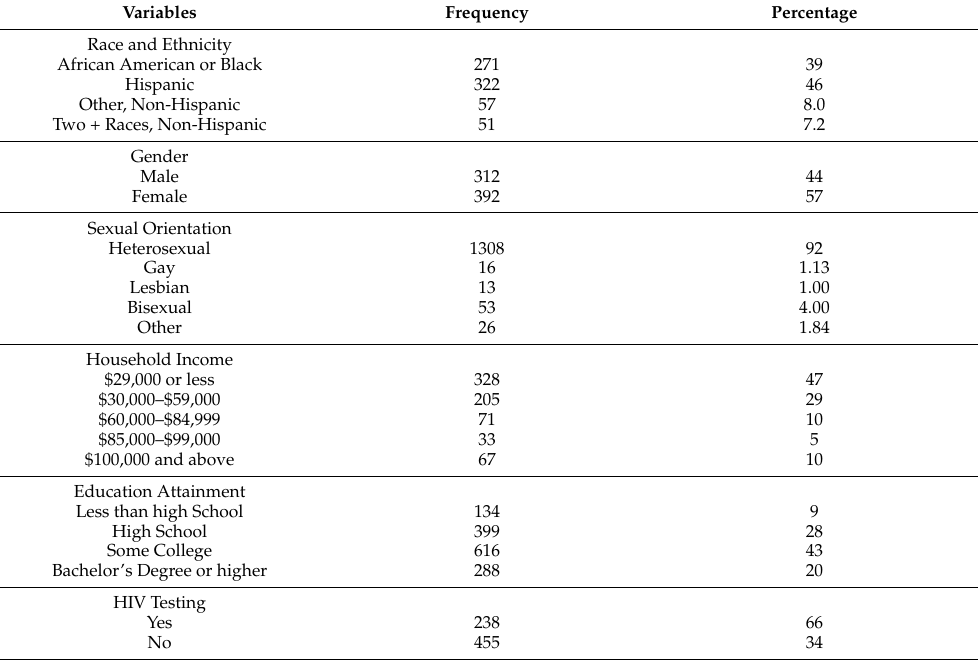
Table 1. Sample Characteristics (N =